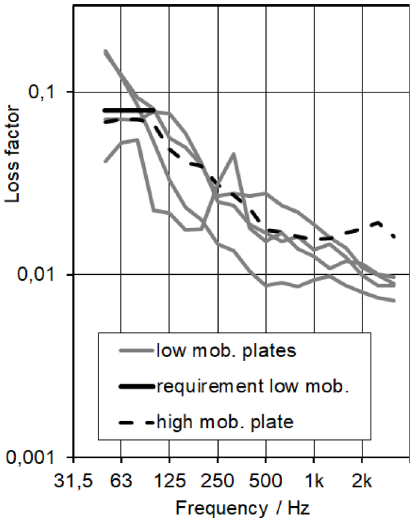
Figure 5. Measured real parts of equivalent mobility of reception plates and mobility magnitude of a mass of 500 g.